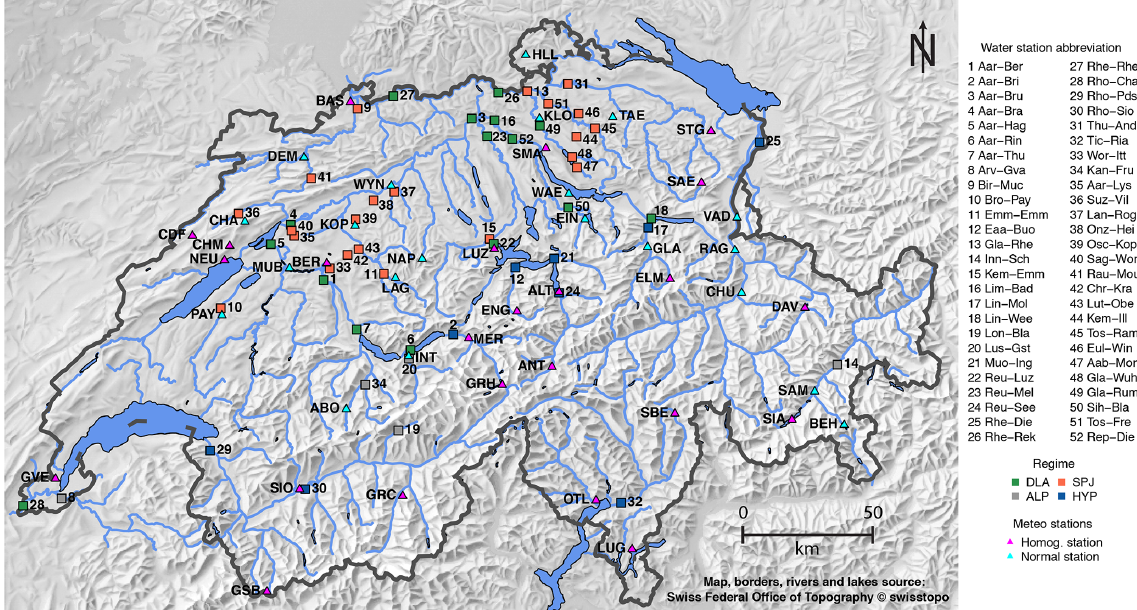
Figure 1. Map of Switzerland showing the selected hydrometric gauging stations and the associated meteorological stations. Abbreviations for hydrometric gauging stations are defined in Table 1, and abbreviations for the meteorological stations are given in Table